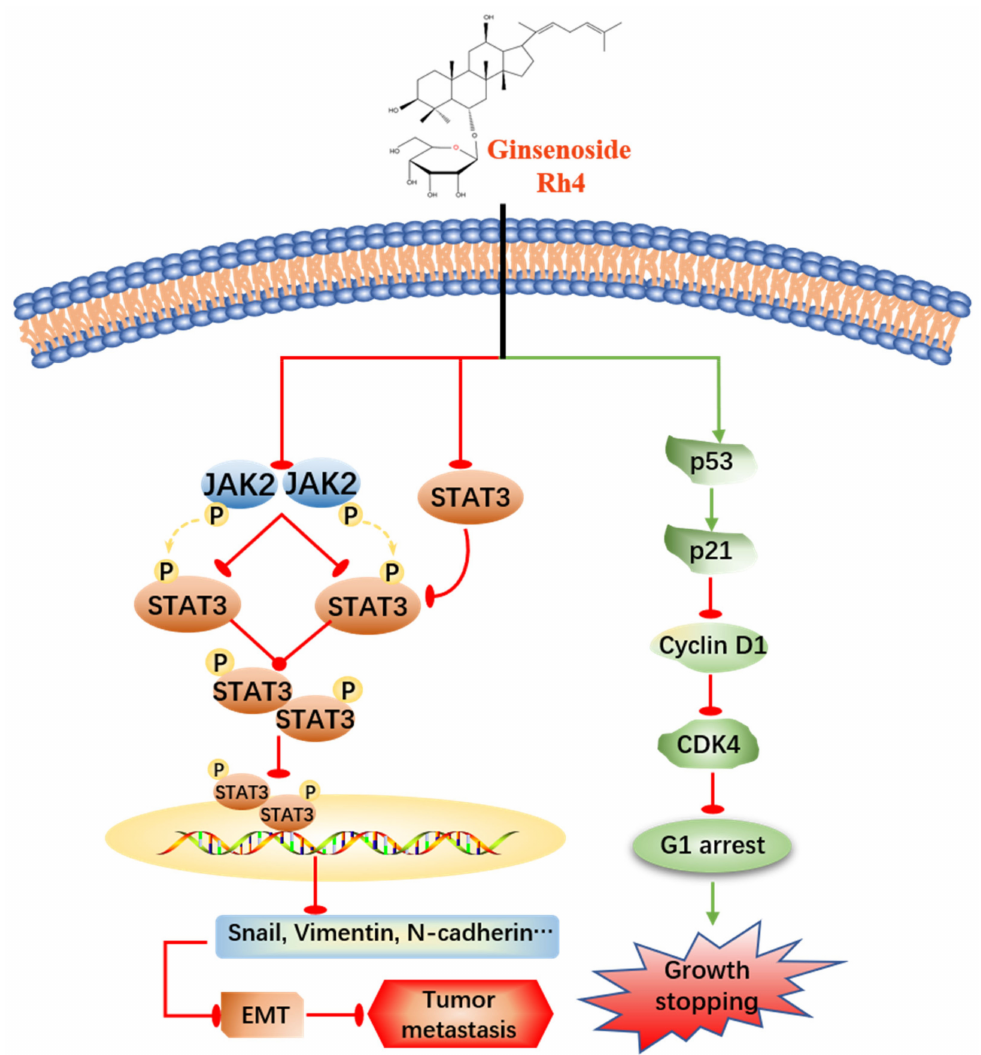
Figure 8. Proposed molecular mechanism of the anti-LAC activity of Rh4. Rh4 inhibited the prolifer- ation of LAC cells via triggering cell cycle arrest in G1 phase and suppressing the EMT procedure by blocking JAK2/STAT3 signaling